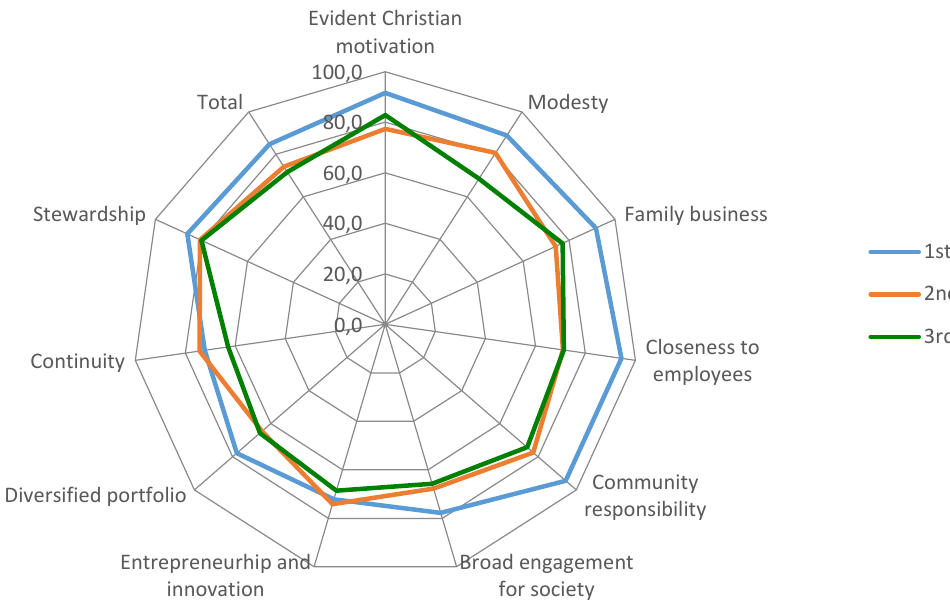
Figure 4. Radar diagram of Haugean business attributes according to